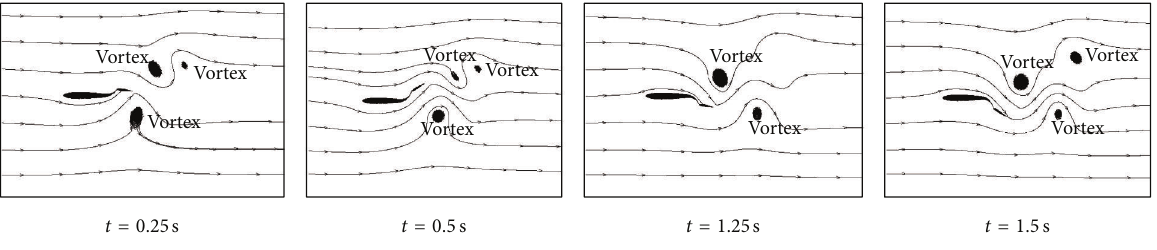
Figure 11: Trailing vortex at 𝜑 = 45 ∘ .